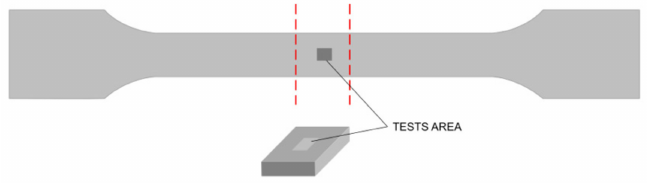
Figure 1. Sample preparation for the